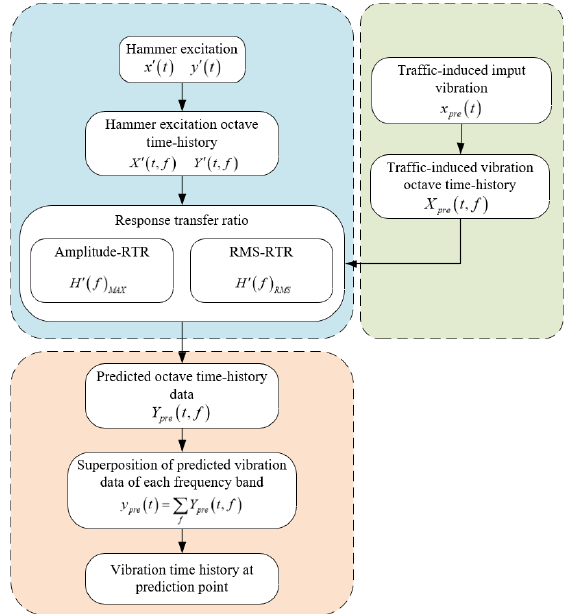
Figure 3. The flowchart of traffic environmental vibration prediction based on the measured RTR.